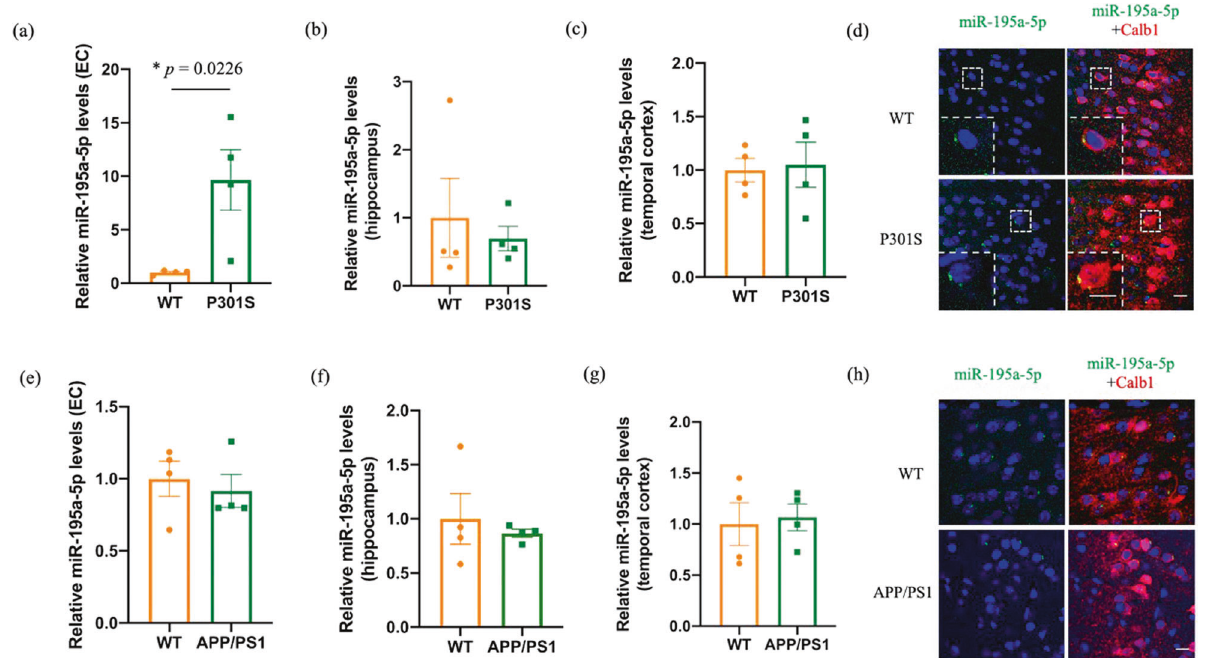
Fig. 2 Results of qPCR and fl uorescence in situ hybridization (FISH) experiments on miR-195a-5p expression in two different AD mouse models compared to controls. a Expression of miR-195a-5p in entorhinal cortex of 6-month-old P301S mice compared to wild-type (WT) mice was assessed by qPCR ( n = 4 for each group). * p -value from unpaired Student ’ s t test was used comparing transgenic vs. WT mice. b , c Expression of miR-195a-5p in hippocampus and temporal cortex of 6-month-old P301S mice compared to WT mice; no signi fi cant differences were identi fi ed. d Fluorescence in situ hybridization (FISH) images of miR-195a-5p which is stained green in EC of 6-month-old P301S and WT mice. The nuclei were stained blue with DAPI. Cabl1 (stained in red) was used as a marker of EC layer II. Scale bar indicates 20 μ m. n = 3 mice in each group. e – h Analogous experiments comparing EC ( e ), hippocampus ( f ) and temporal g cortex and performing FISH staining ( h ) in 6-month-old APP/PS1 mice compared to WT